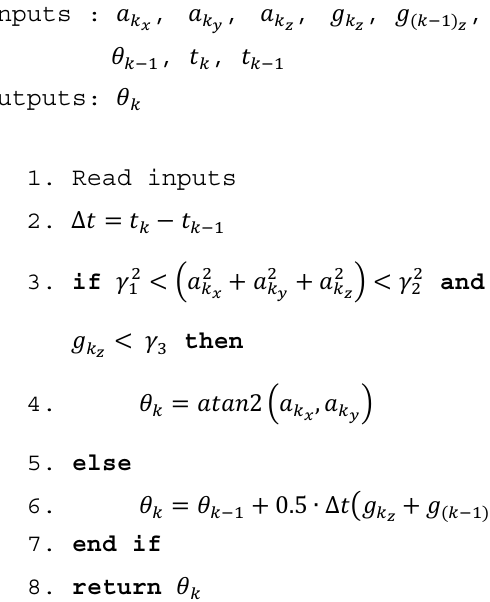
Figure 6. Gyro Integration-Based Orientation Filter (GIOF). a i ( i = x , y , z ) is the acceleration of i axis measured at time stamp k ; g k and g ( k − 1 ) are gyroscope z axis reading measured at time stamps k and ( k − 1); t k and t k − 1 are the time values of time stamps k ; and ( k − 1); θ k − 1 is the previous estimation of thigh angle and θ k is the current estimation of thigh angle.